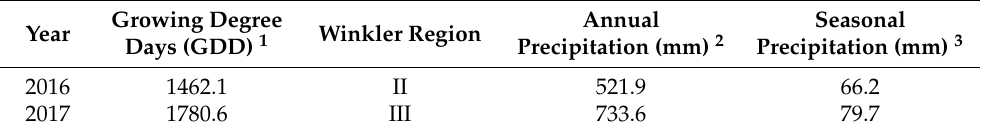
Table 1. Growing degree days (GDD); Winkler region classification; and precipitation for San Luis Obispo, California